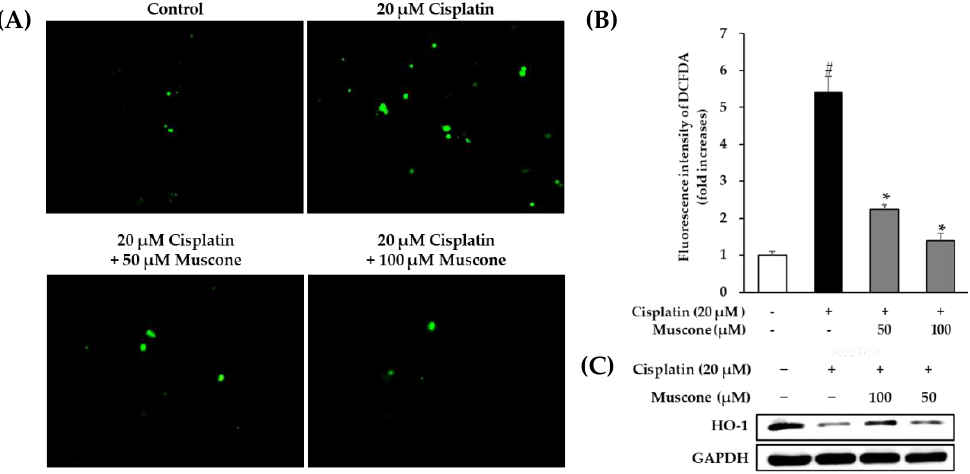
Figure 3. Preventive effect of muscone against cisplatin induced oxidative stress in kidney proximal tubule LLC-PK1 cells. ( A ) After 24 h treatment with specific doses of muscone in the presence or absence of cisplatin, LLC-PK1 cells were stained with 10 µM DCFDA for 30 min. The images were obtained using an IX51 fluorescence microscope (Olympus, Tokyo, Japan) connected to a CCD camera. ( B ) The bar chart describes the fold increases in DCFDA fluorescence intensity analyzed from images using ImageJ software. ( C ) The effect of muscone on expression of HO-1 after 24 h exposure to indicated concentration of muscone and 20 µM cisplatin in LLC-PK1 cells. The data are described as the mean ± SD ( N = 2). Notes: # p < 0.05 compared with the control group, * p < 0.05 compared with the cisplatin treated group.